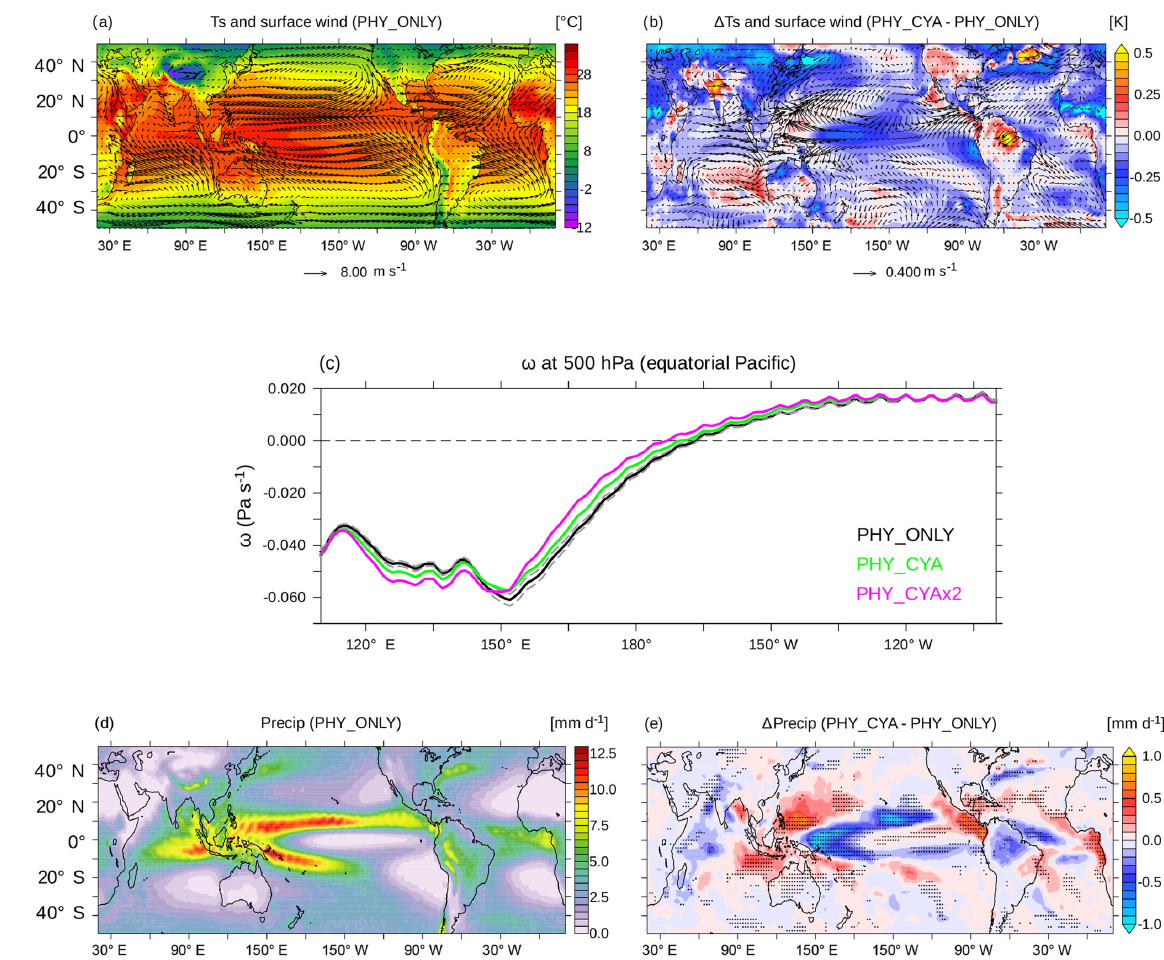
Figure 5. (a) Climatological mean surface air temperatures ( ◦ C) and vectors of surface winds (ms − 1 ) in PHY_CYA. (b) Difference in the climatological annual mean surface air temperature (K) and vectors of surface wind anomalies (ms − 1 ) between PHY_CYA and PHY_ONLY. (c) Climatological mean vertical velocity ω (Pas − 1 ) at 500hPa above the equatorial Pacific (10 ◦ S–10 ◦ N) in PHY_ONLY (black, ± 2 times the standard deviation of eight 100-year periods of CTRL in dashed grey), PHY_CYA (green) and PHY_CYAx2 (purple). (d) Climatological annual mean precipitation (mmday − 1 ) in PHY_CYA. (e) Difference in the climatological annual mean precipitation (mmday − 1 ) between PHY_CYA and PHY_ONLY. The dotted areas indicate statistically significant anomalies at the 90% confidence level (student’s t